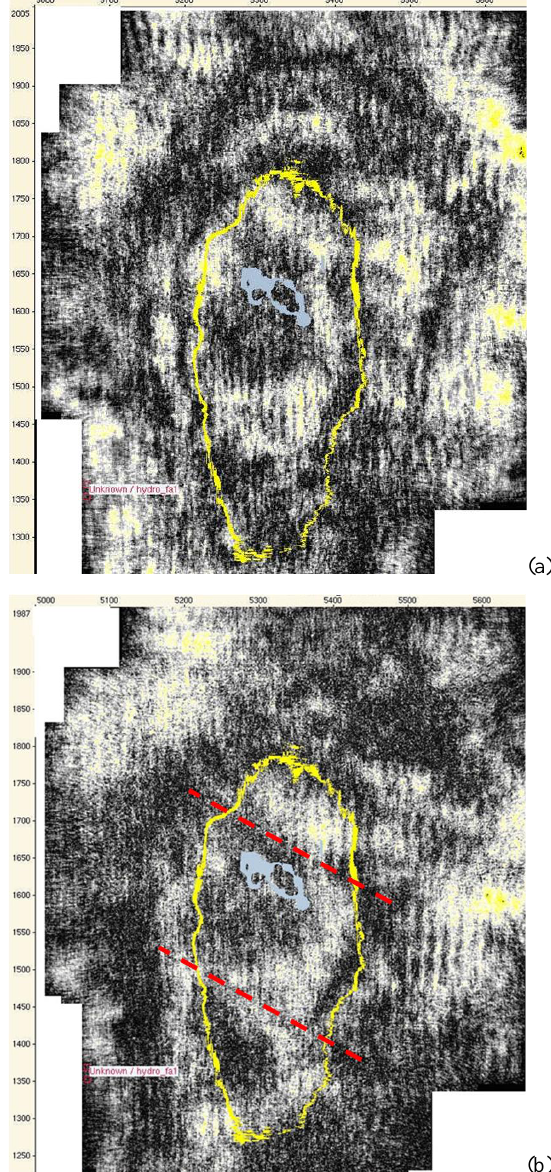
Fig. 4. Comparison between two main methods of spectral decom- position. (a) FFT and (b) CWT results. Red dashed lines in (b) dis- play the abilities and advantages of the CWT technique in fault de- tection and illustration better than the FFT